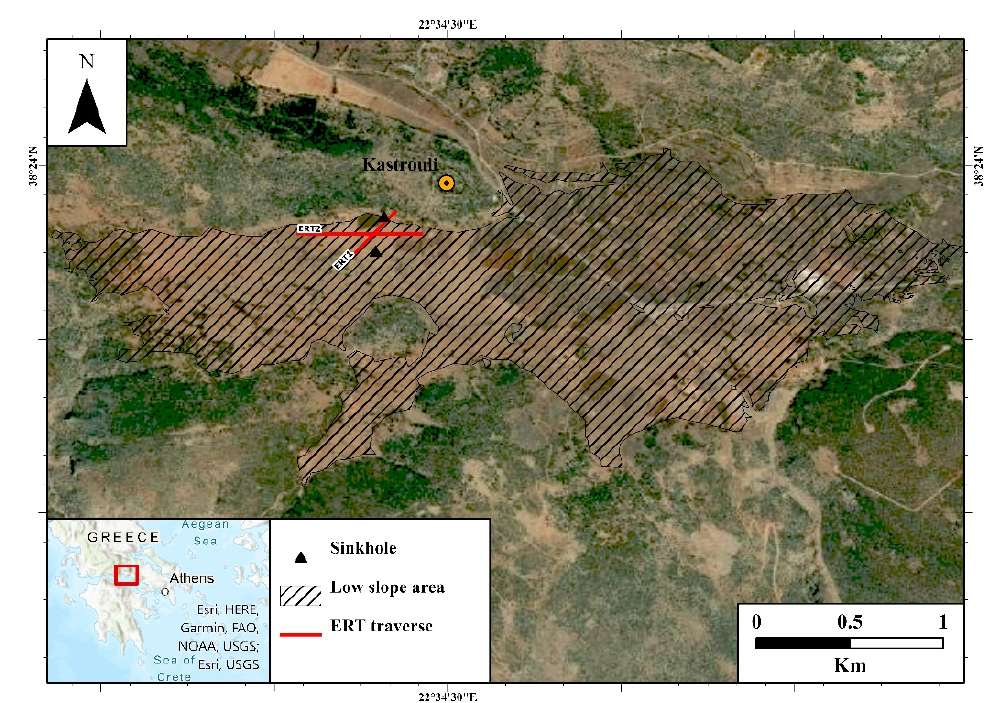
Figure 9. The (northeast) map, derived from the high-resolution digital elevation model, showing the position of the sinkholes, the two ERT traverses (red) and the relatively low slope area.